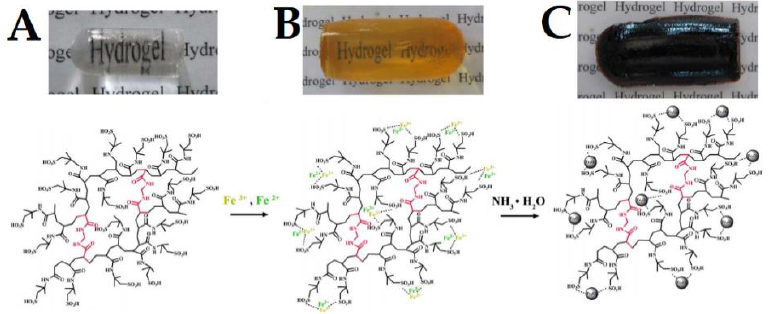
Figure 1. Schematic representation of the PAMPS based magnetogel preparation, where ( A ) the hydrogel is immersed in a Fe (II) and Fe (III) ion-containing aqueous solution which ( B ) are absorbed by the hydrogel network. The nanoparticles are then formed by co-precipitation in an ammonia aqueous solution that ( C ) results in the magnetogel. Adapted from [57] with permission from John Wiley and Sons, 2015.